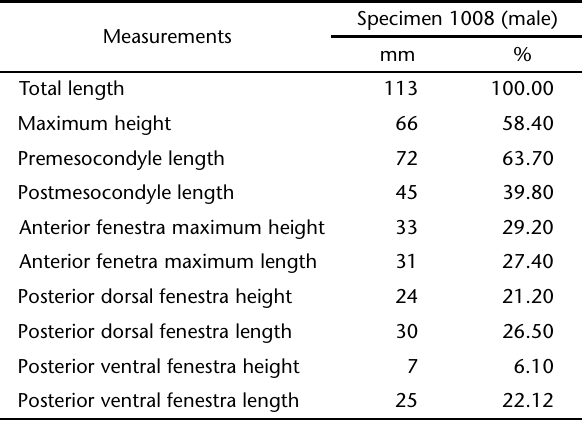
Table V. Measurements (mm) of the scapulocoracoid taken from one specimen of D. mennii . Percentages are in relation to scapulocoracoid total length; specimen is from the UERJ collection.